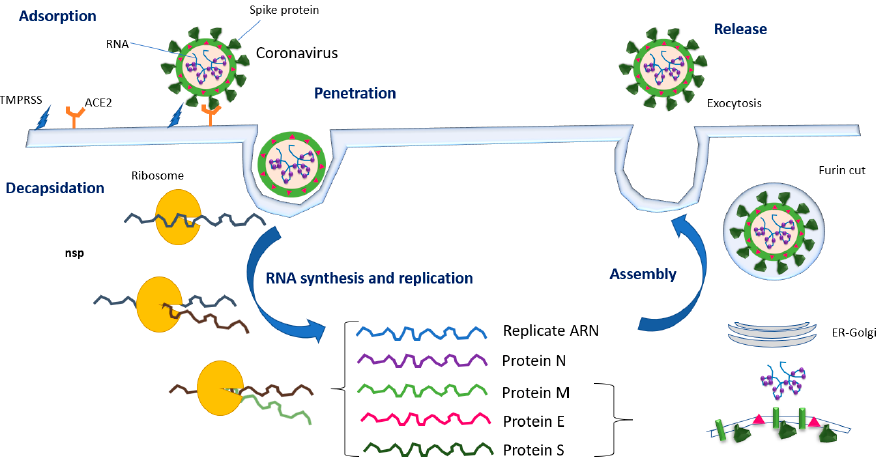
Figure 1. Schematic representation of the SARS-CoV-2 virus life cycle (adapted from Abu-Farha, 2020 2020 [21]).